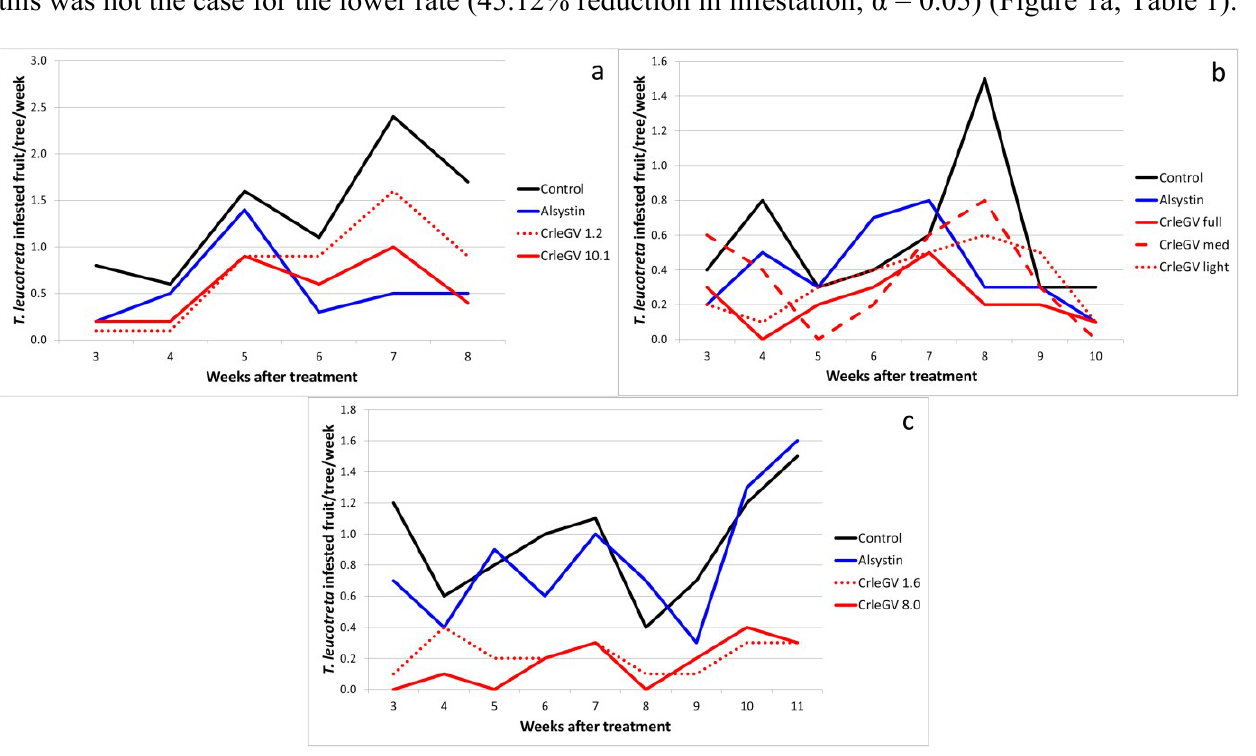
Figure 1. Thaumatotibia leucotreta -infested fruit per tree per week at ( a ) Sun Orange Farm. The trial was sprayed on 5 April 2001; ( b ) Vergenoeg Farm. The trial was sprayed on 14 March 2002; ( c ) Moosrivier Farm. The trial was sprayed on 16 January 2003. Concentrations given for CrleGV in ( a ) and ( c ) are × 10 14 OBs per ha. (See Table 3 for full treatment application details; see Table 1 for means and standard errors for the full period of